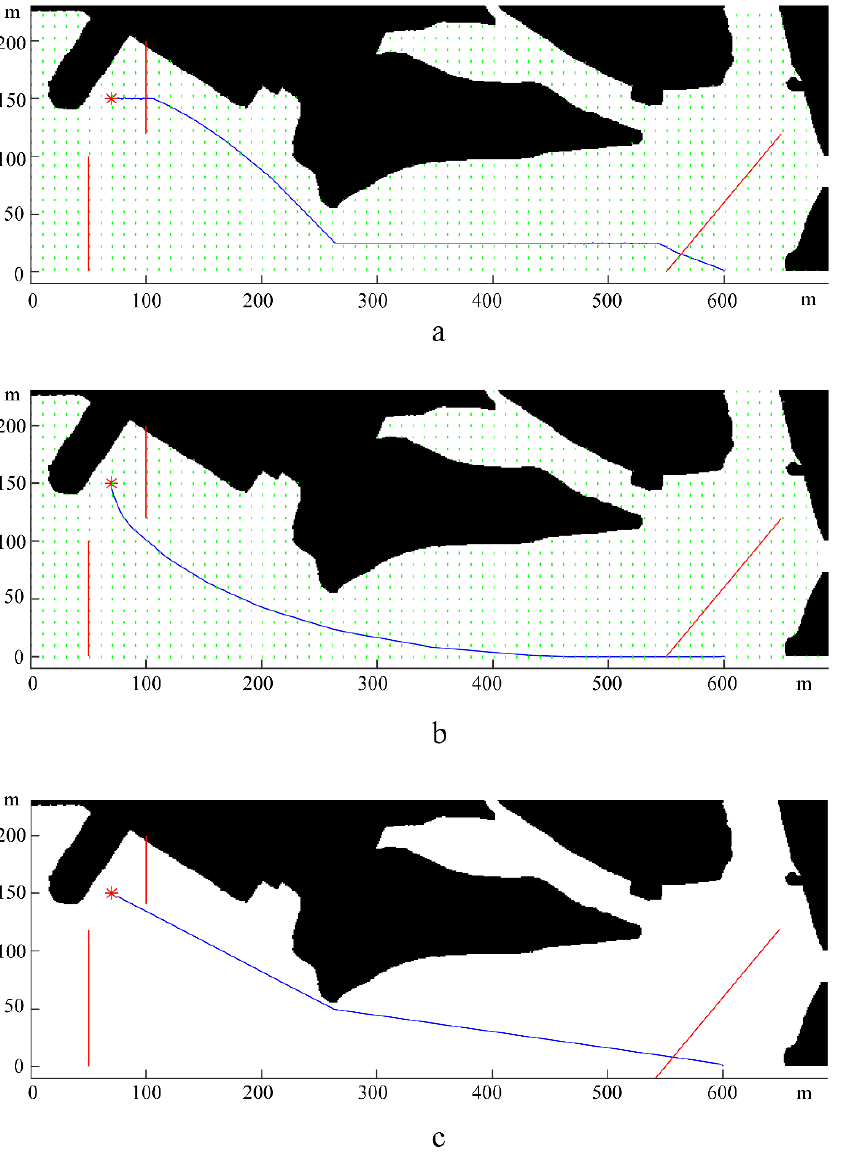
Figure 5. Final path under upward loads ( a ), downward loads ( b ), and in still water ( c ). Where “*” represents for the final destination, the red lines represent for the paths of dynamic obstacles, and the blue line represents for the simulated navigation path in each subfigure.